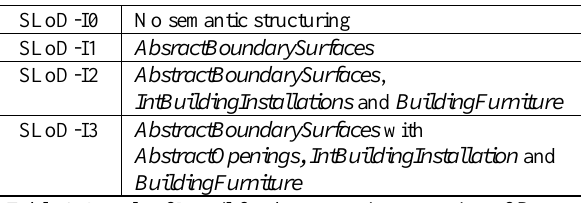
Table 2: Levels of Detail for the geometric representation of a